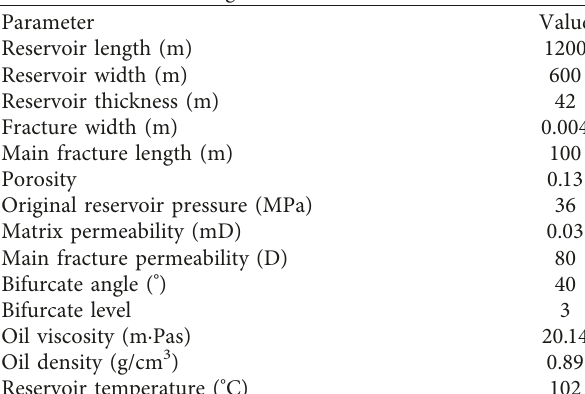
Table 1: Basic data of a tight oil reservoir with bottom water drive.